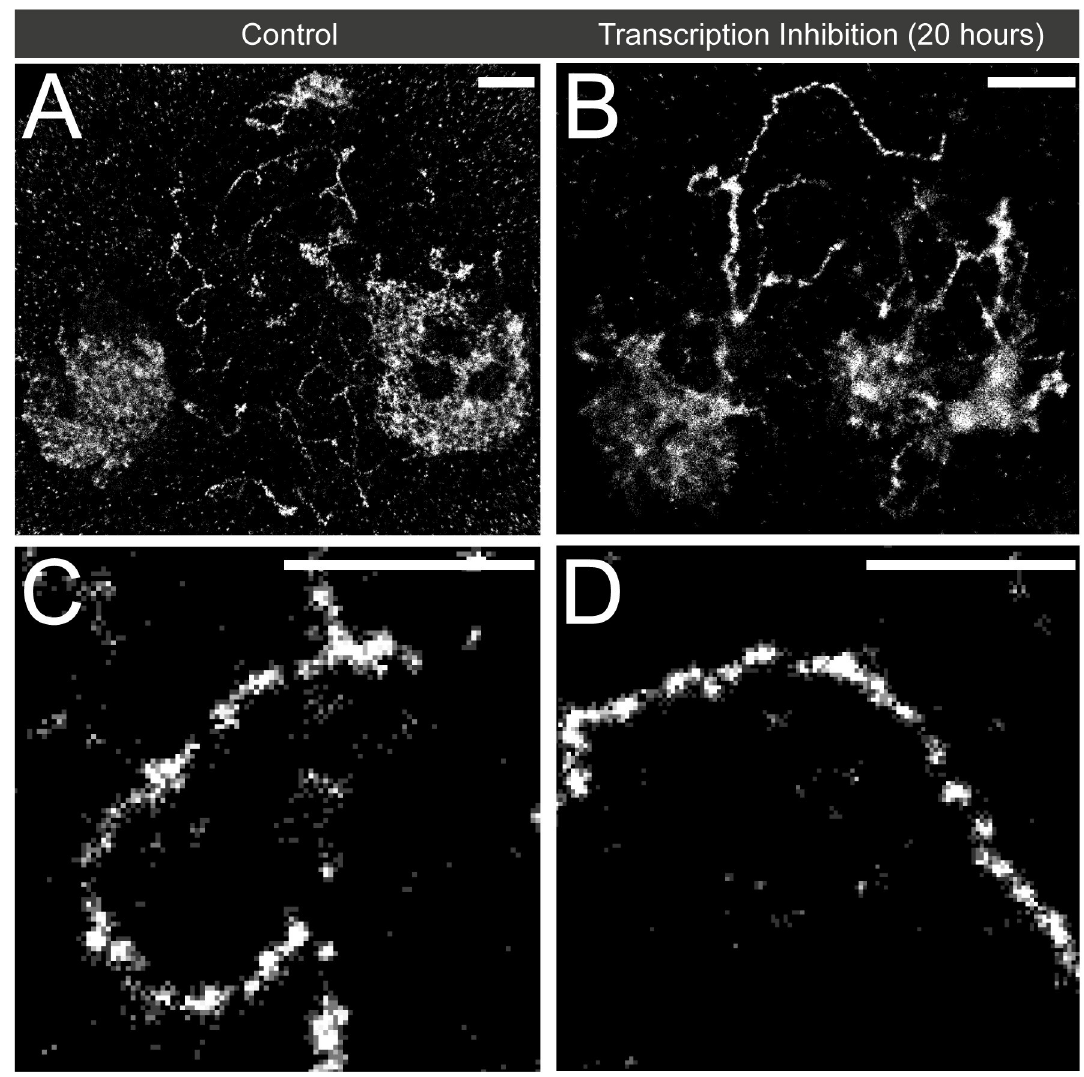
Fig 9. The effect of transcription inhibition on Y loop chromatin. (A) An example of a control spermatocyte nucleus with the histone labelled. An autosome is present on the left side of the nucleus, and the nucleolus is on the right side of the nucleus. (B) An example of a spermatocyte nucleus after 20 hours of transcription inhibition using α -amanitin and triptolide. An autosome is also shown on the left side of the nucleus, and the nucleolus is present on the right side of the nucleus. (C) A zoomed in image showing the clusters along the Y loops in the control cell. (D) A zoomed in image showing the clusters along the Y loops in the spermatocytes after transcription inhibition. The scale bars are 2 μ m in (A) and (B), the scale bars are 1 μ m in (C) and (D).